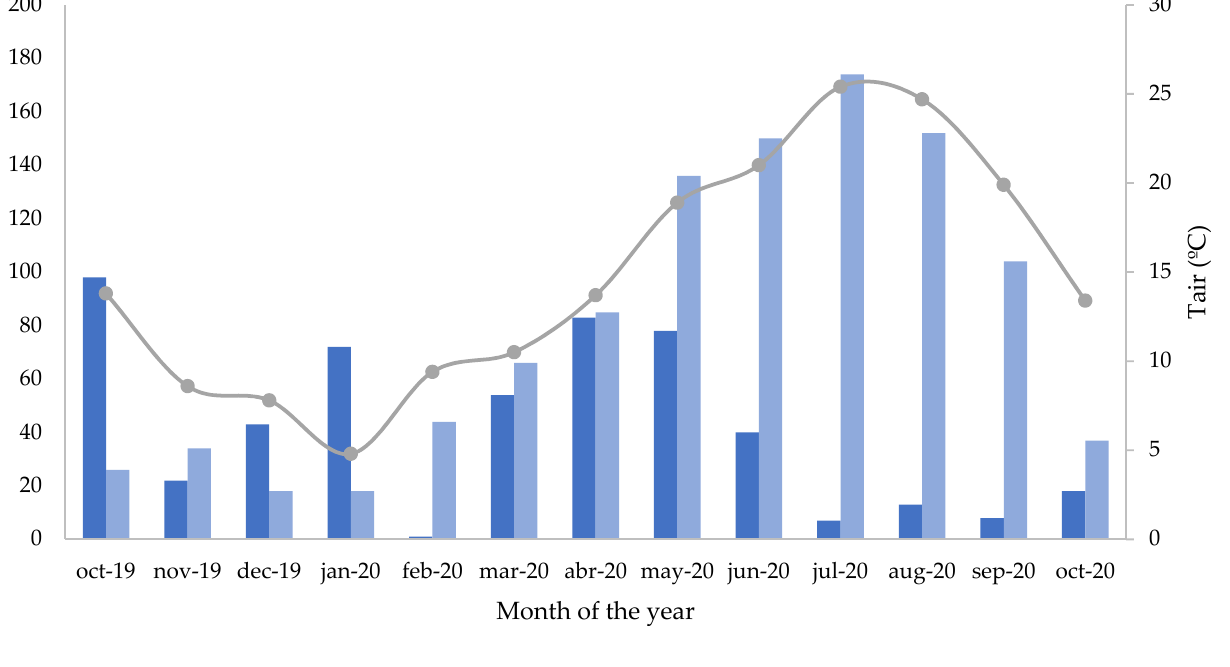
Figure 2. Average daily temperature (Tair), monthly cumulative rainfall (R) and monthly reference evapotranspiration (ET o ) during the study period in the Albesa station. From 15 October 2019 to 15